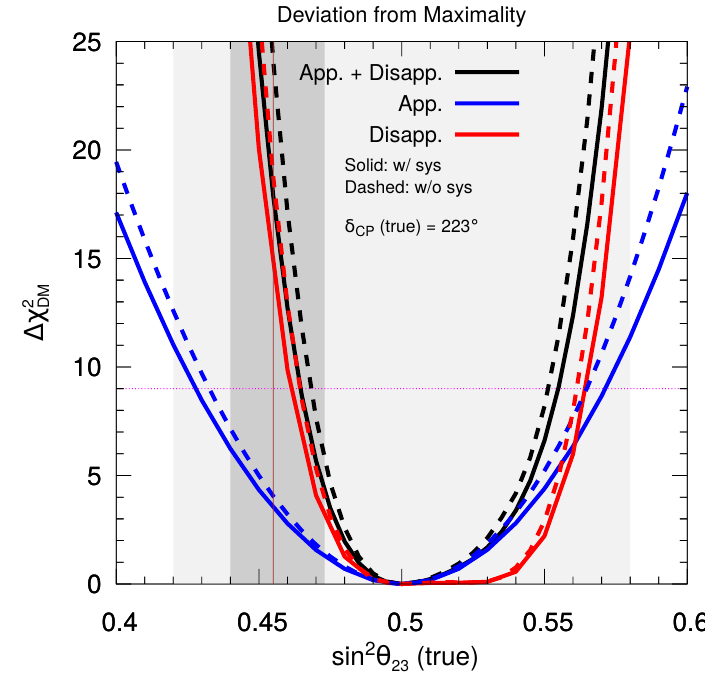
Figure 7 . Performance of DUNE to establish deviation from maximality as a function of true sin 2 θ assuming true NMO and δ (true) = 223 ◦ with 7 years of exposure equally divided in 23 CP ν and ¯ ν modes. Red, blue, and black curves show the sensitivity obtained using disappearance channel, appearance channel and their combinations, respectively. The solid (dashed) lines depict the results with (without) systematic uncertainties. In the fit, we marginalize over the current 3 σ range of ∆ m 2 and δ , while keeping rest of the oscillation parameters fixed at their present best-fit CP 31 values as shown in table 1. The dark (light)-shaded grey area shows the currently allowed 1 σ (2 σ ) region in sin 2 θ as obtained in the global fit study [11] assuming NMO with the best-fit value of 23 sin 2 θ = 0 . 455 as shown by vertical brown line. The capability of DUNE to establish non-maximal 23 = 9 ) confidence level is shown by horizontal pink dotted θ 23 at 3 σ ( ∆ χ 2 DM